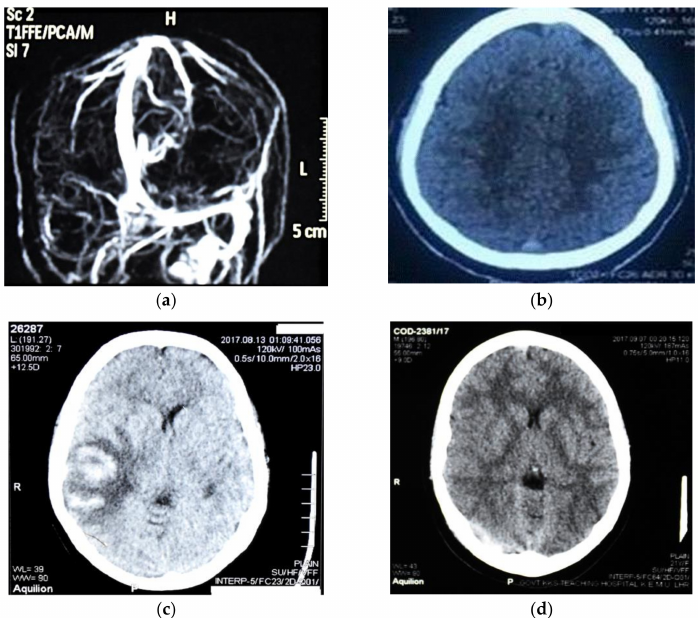
Figure 1. Imaging details of the complications presented in CVST patients: ( a ) sagittal contrast enhanced MRV showing filing defect in right transverse and sigmoid sinus; ( b ) CT scan brain plain showing delta sign suggestive of superior sagittal sinus thrombosis; ( c ) CT scan brain plain showing mixed density lesion not following vascular territory suggestive of transverse sinus thrombosis; ( d ) non-enhanced CT showing hyper-dense transverse